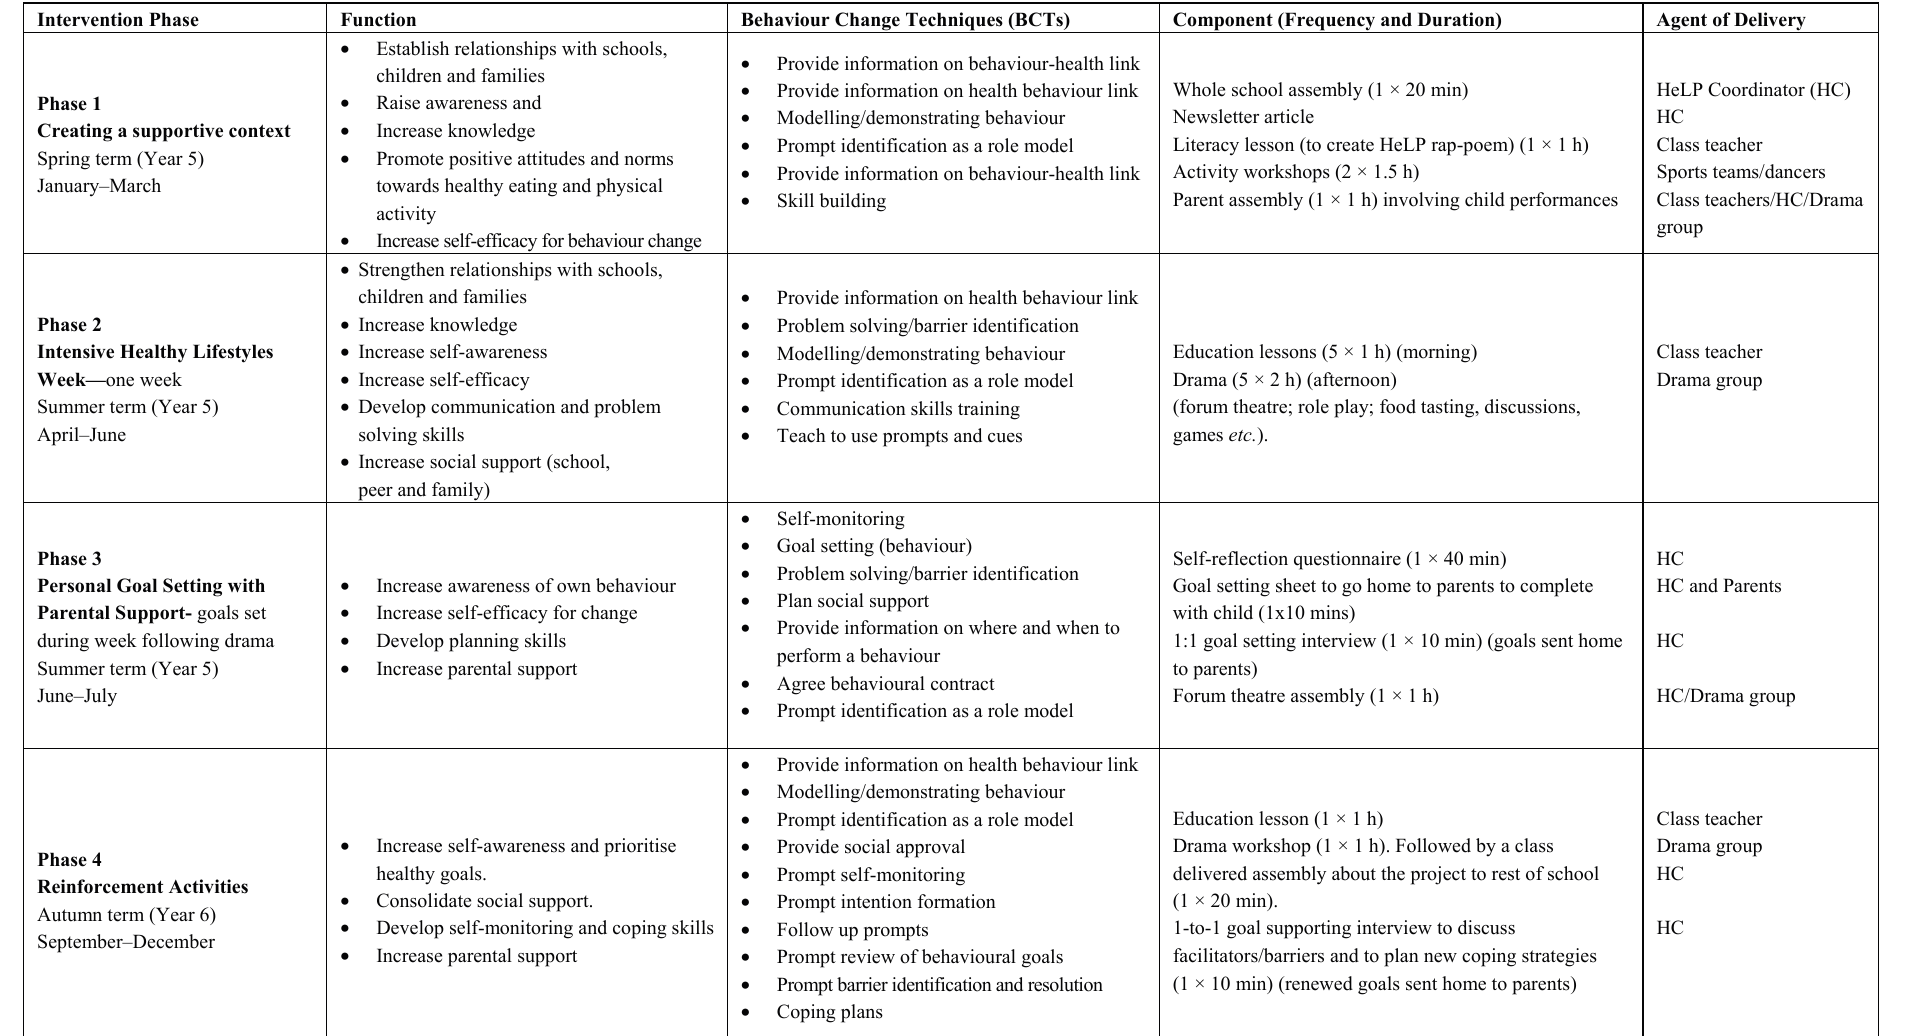
Table 1. Intervention phases, function, BCTs and the component and agent of